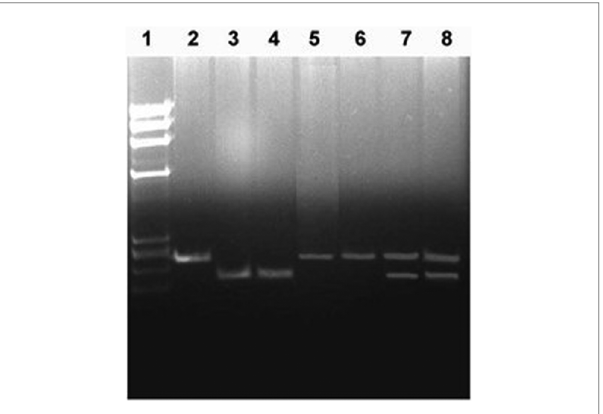
FIGURE 1 Detection of IL4 gene ( – C950T, rs2243250) polymorphism genotypes. Lane 1, Hae II cleaved ϕ X174 DNA M r size markers; lane 2, un-cleaved PCR product (252 bp); lane 3 – 4, PCR products cleaved with